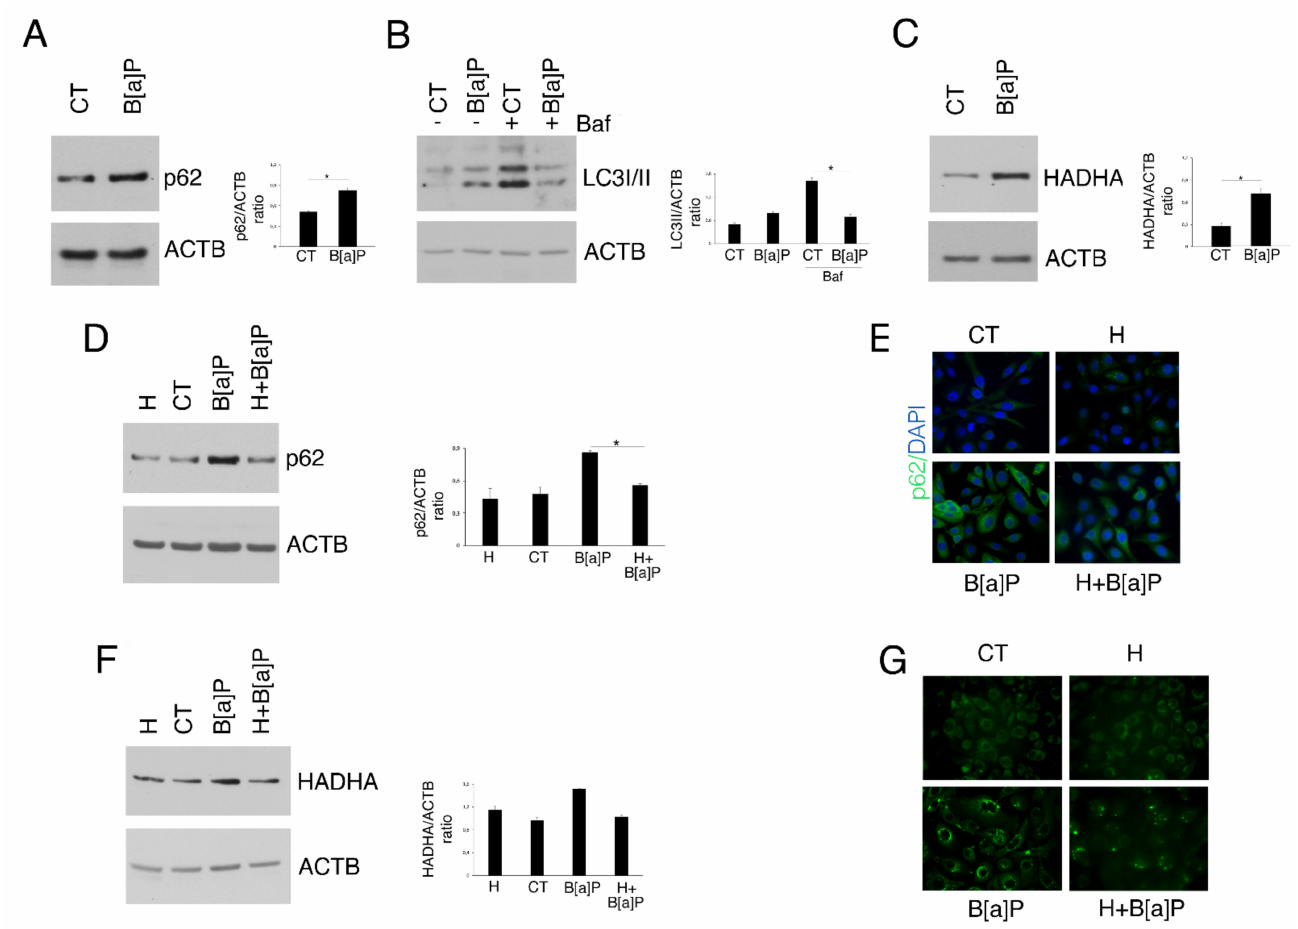
Figure 4. Hydroxytyrosol (H) rescues the B[a]P-mediated impairment of autophagy and mitophagy in HCoEpC. ( A ) SQSTM1/p62 (p62) level in HCoEpC treated with B[a]P (5 µ M) for 6 days was assessed by Western blotting. ( B ) LC3II level in HCoEpC treated with B[a]P (5 µ M) for 6 days in presence or not of Bafilomycin A1 (Baf; 20 nM for further 4 h) was evaluated by Western blotting. ( C ) HADHA amount in HCoEpC treated with B[a]P (5 µ M) for 6 days assessed by Western blotting. ( D , E ) SQSTM1/p62 (p62) expression in HCoEpC treated with H (1 µ M) and/or B[a]P (5 µ M) for 6 days was analyzed by Western blotting and IFA. Nuclei were stained with DAPI. IFA was visualized by fluorescence microscopy, at 20 × magnification. ( F ) HADHA in HCoEpC treated with H (1 µ M) and/or B[a]P (5 µ M) for 6 days evaluated by Western blotting. ( G ) To stain mitochondria, HCoEpC treated with H (1 µ M) and/or B[a]P (5 µ M) for 6 days were incubated with MitoTracker Green